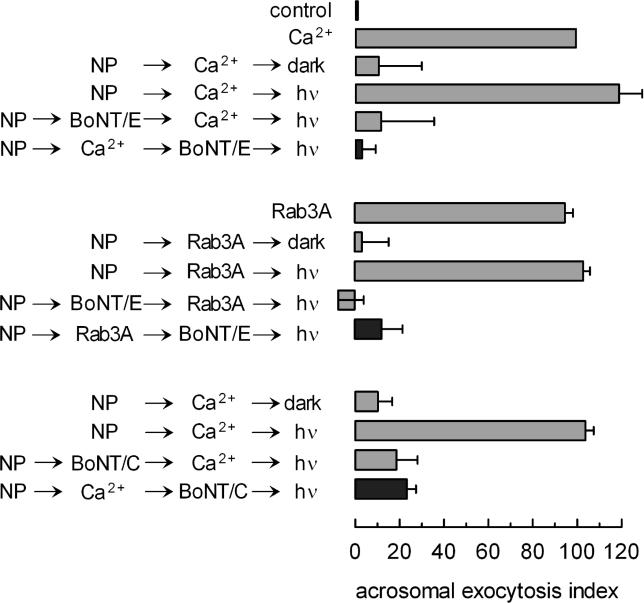
SNAREs Do Not Reassemble in Tight Complexes before the Efflux of Intra-Acrosomal Ca2+
Permeabilized spermatozoa were loaded with 10 μM NP-EGTA-AM (NP) for 15 min at 37 °C to chelate intra-acrosomal Ca2+. AE was then initiated by adding 10 μM free Ca2+ (Ca2+) or 300 nM Rab3A (Rab3A). After 15 min incubation at 37 °C to allow exocytosis to proceed to the intra-acrosomal Ca2+-sensitive step, neurotoxins recognizing SNAP25 (BoNT/E) and syntaxin (BoNT/C) were added to the tubes to assess whether the SNAREs had reassembled into toxin-resistant complexes. Intra-acrosomal Ca2+ was replenished by photolysis of NP (hν), and samples were incubated for 5 min to promote exocytosis (NP→Ca2+/Rab3A→neurotoxins→hν, black bars). Sperm were then fixed and AE measured as described in Materials and Methods. Several controls are included (grey bars): background AE in the absence of any stimulation (control); AE stimulated by 10 μM free Ca2+ (Ca2+) or Rab3A (Rab3A); inhibitory effect of NP-EGTA-AM in the dark (NP→Ca2+/Rab3A→dark) and recovery upon illumination (NP→Ca2+/Rab3A→hν); and AE inhibition when neurotoxins were present throughout the incubation (NP→neurotoxins→Ca2+/Rab3A→hν). The data were normalized as described in Materials and Methods (mean ± SEM). Statistical analysis is provided in Table S6.